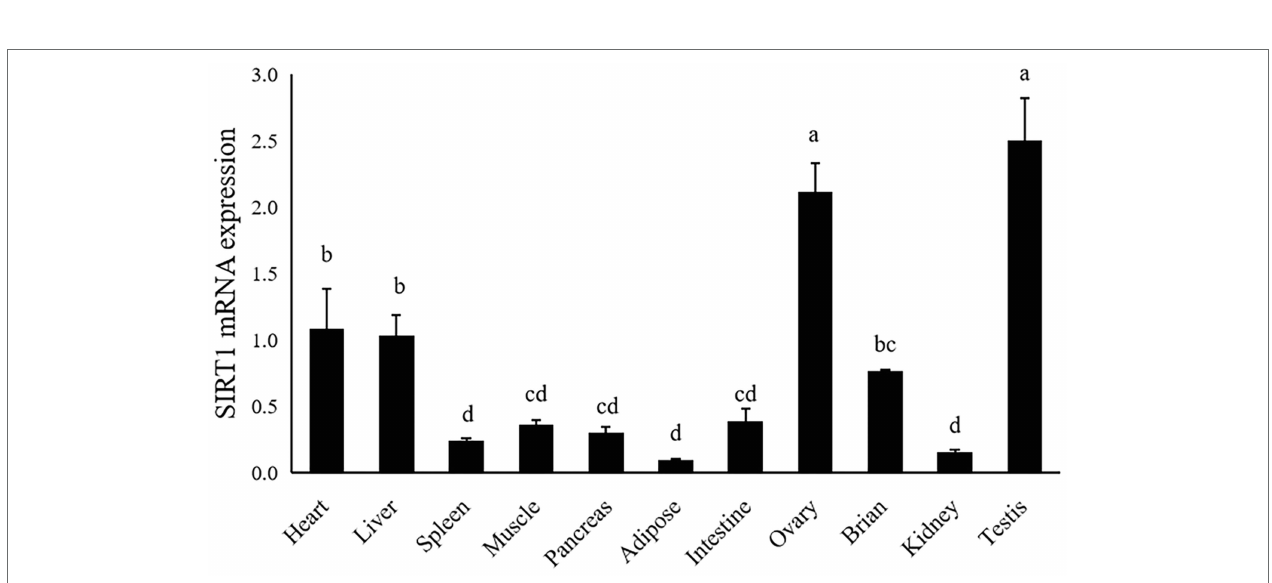
FIGURE 4 | Tissue distribution of SIRT1 in largemouth bass. The same lower-case letters indicate no significant differences ( p > 0.05; Duncan’s